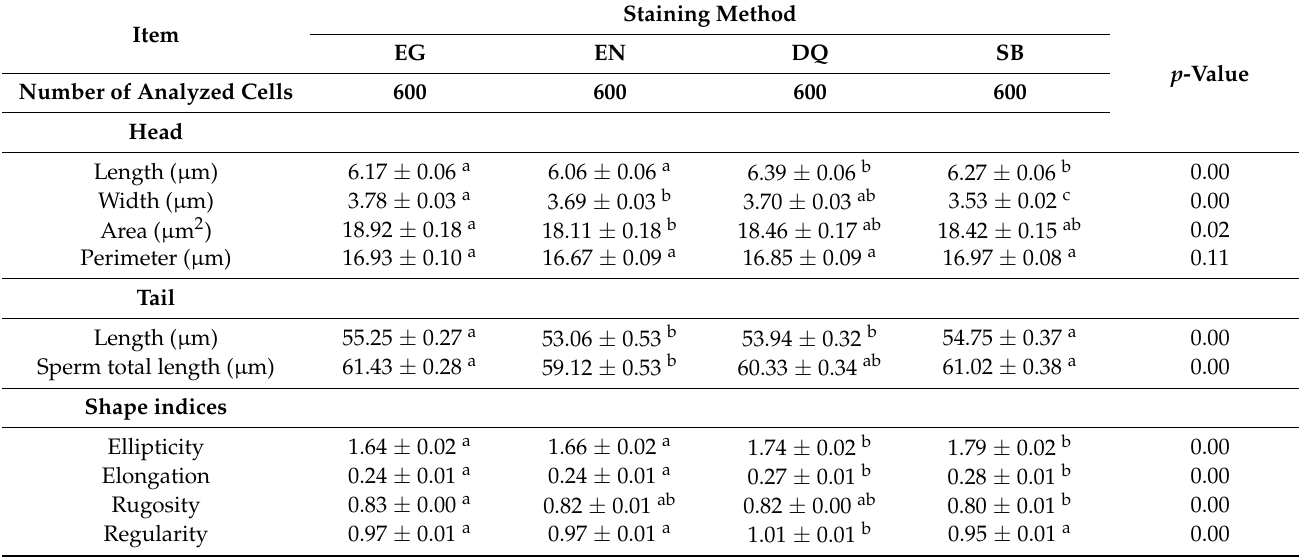
Table 2. Morphometry of sperm collected from the epididymides of dogs depending on the staining method (EG, EN, DQ, SB) (mean ±